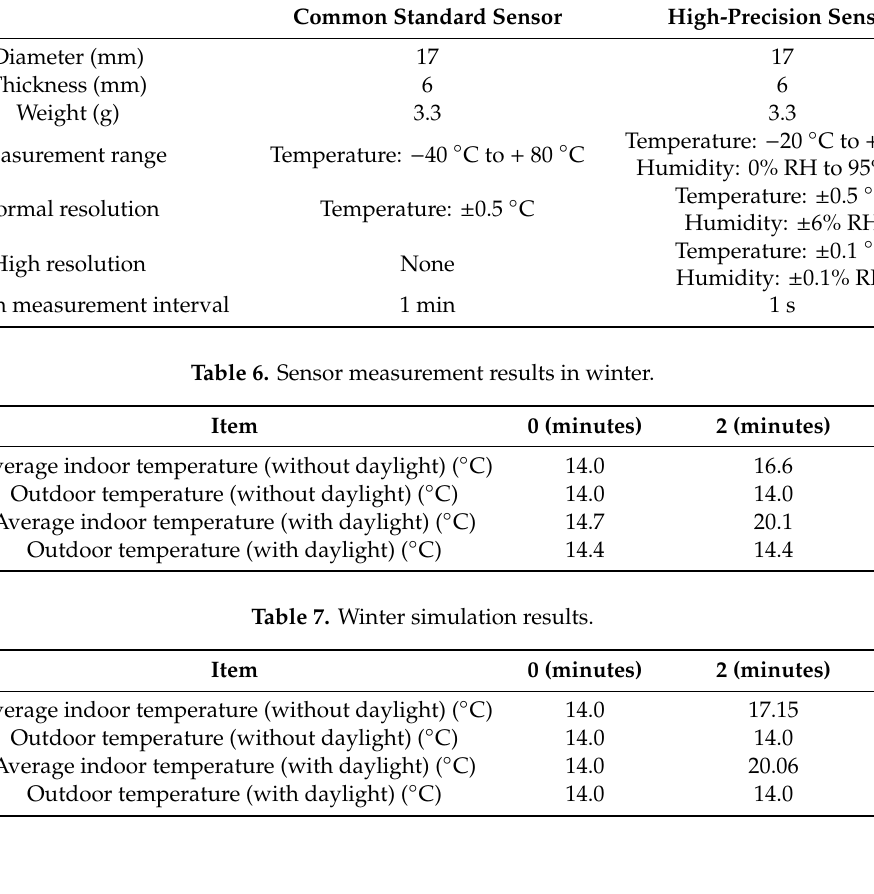
Figure 11. Sensor setting position. Table 5. Sensor specifications.